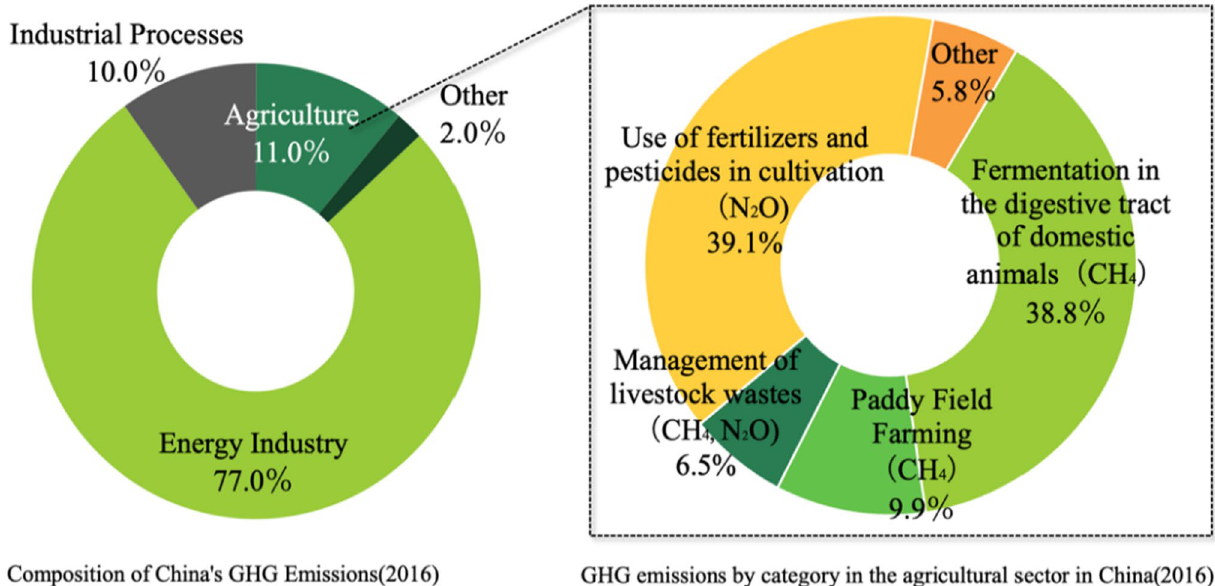
Fig. 1 Overview of China’s greenhouse gas (GHG) emissions